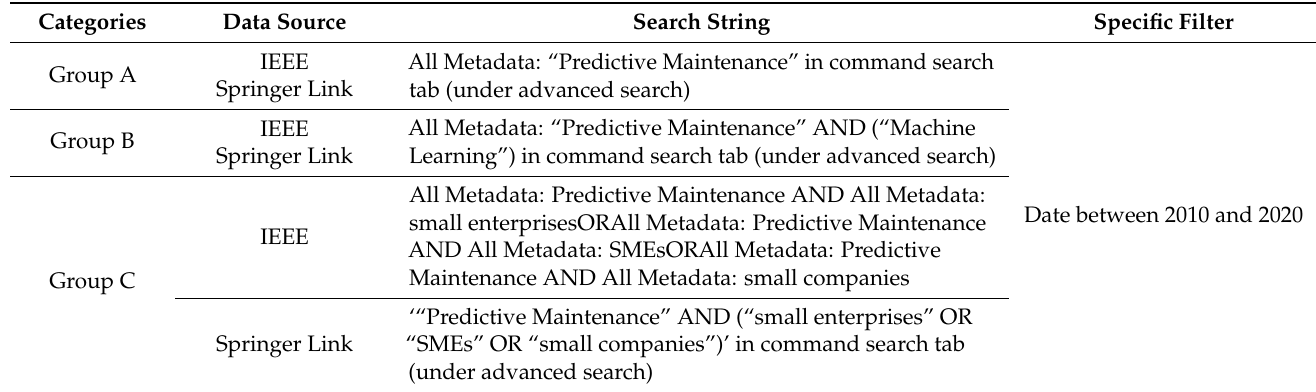
Table 1. Search strings for selected data